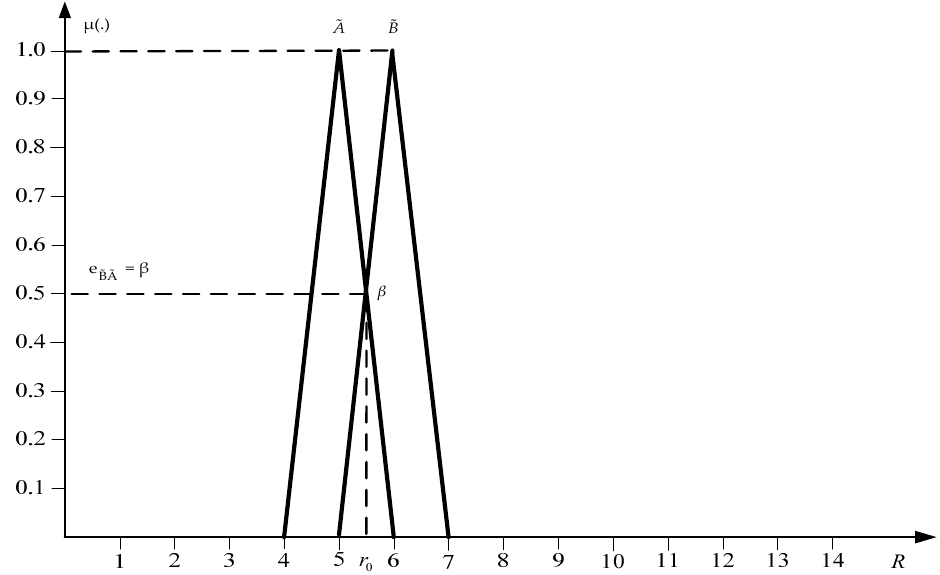
Figure 5. Graphical representation of the simplified method for comparing fuzzy numbers. Value of β is assessed subjectively. In this paper, β = 0.5 as a compromise.